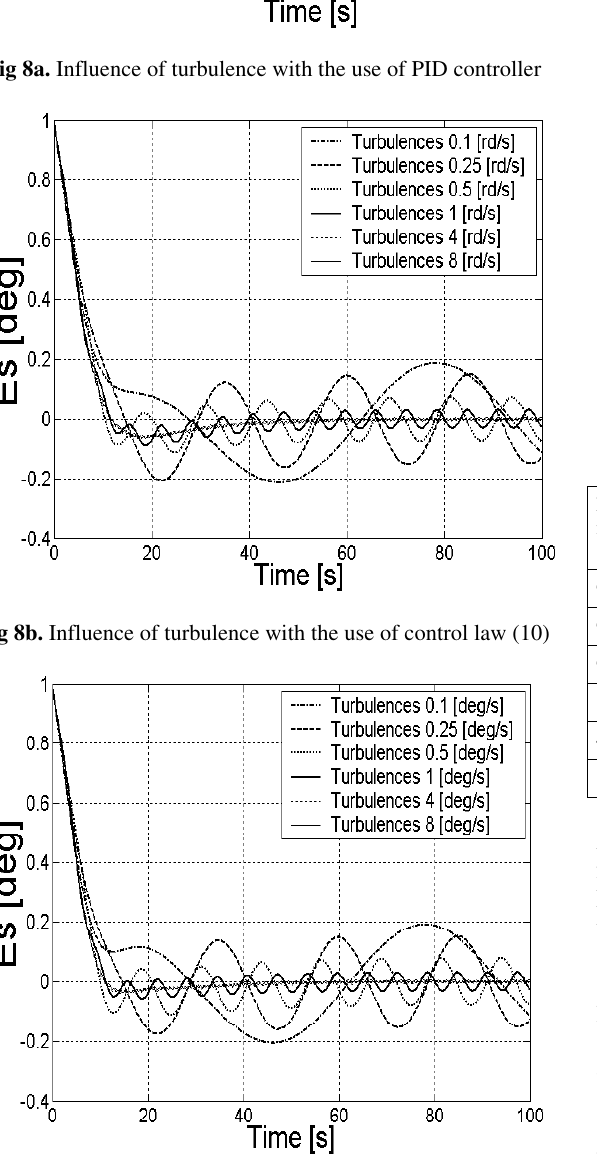
Fig 8c. Influence of turbulence with the use of control law (12)